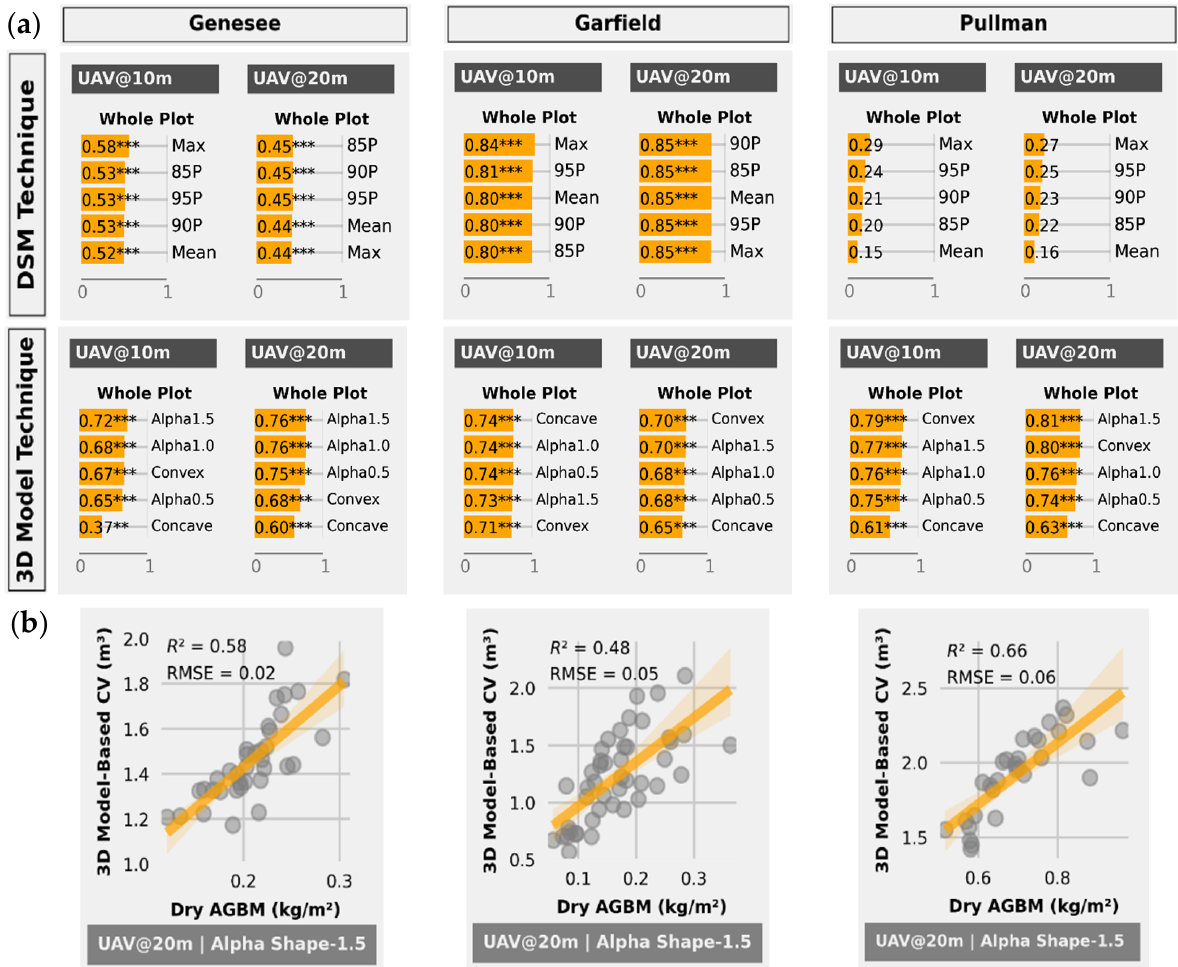
Figure 7. Relationships between ground reference data and digital canopy volume traits (at PM stage) extracted from UAV imagery from three trials at Genesee, Garfield, and Pullman: ( a ) correlation coefficients based on digital traits extracted from DSM and point cloud data; ( b ) linear regression between 3D model-based alpha-shape ( α = 1.5) CV and ground reference data. CV : canopy volume; 3D model technique —Alpha1.5: alpha shape ( α = 1.5); Alpha1.0: alpha shape ( α = 1.0); Alpha0.5: alpha shape ( α = 1.5); Concave: concave hull; Convex: convex hull. Significant probability level: ** 0.01, and *** 0.001.